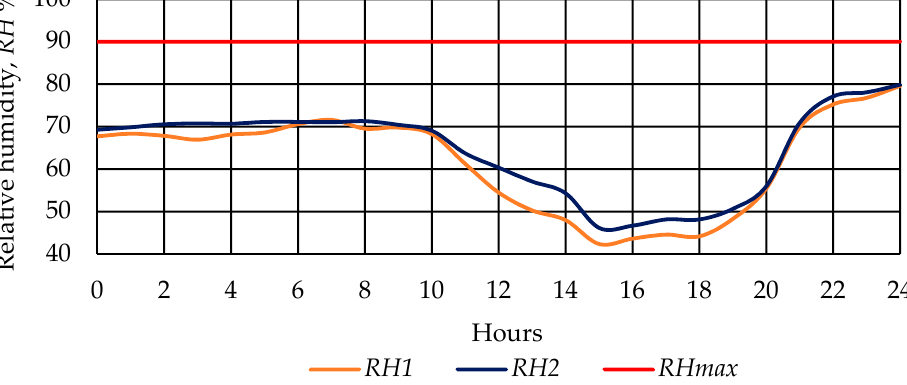
Figure 12. Dynamics of relative humidity on a hot day (maximum temperature of 32.2 °C ).